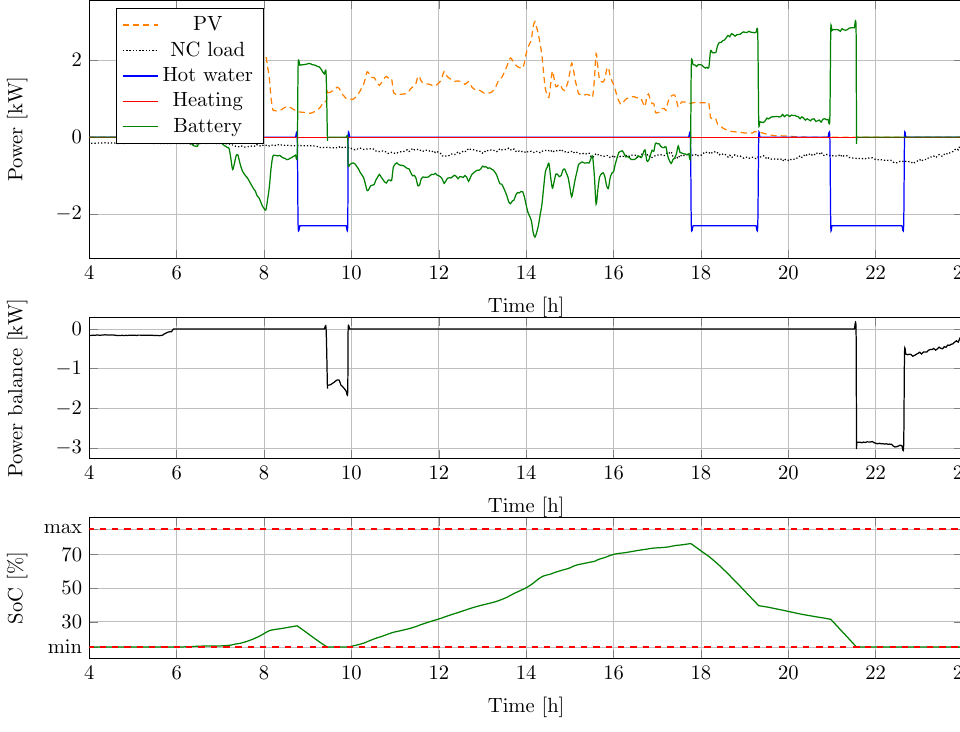
Figure 13. Power consumption/generation of devices for the summer cloudy day scenario. The upward and downward flexibility capabilities of each device were added, result- ing in the building’s maximum flexible power (Figure 14).